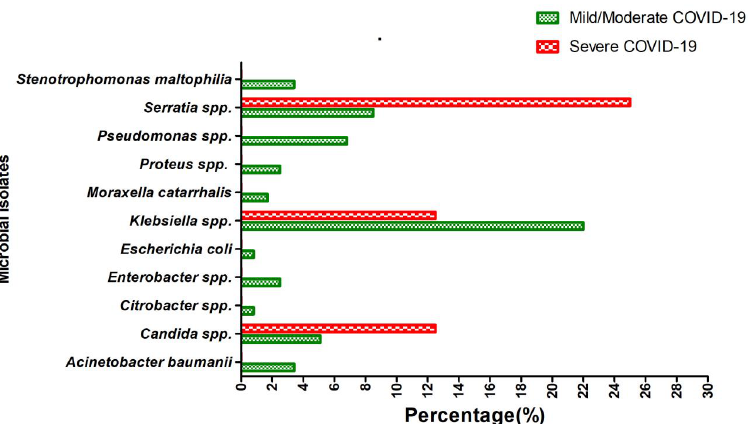
Table 4. Microbial risk factors associated with COVID-19 infection .